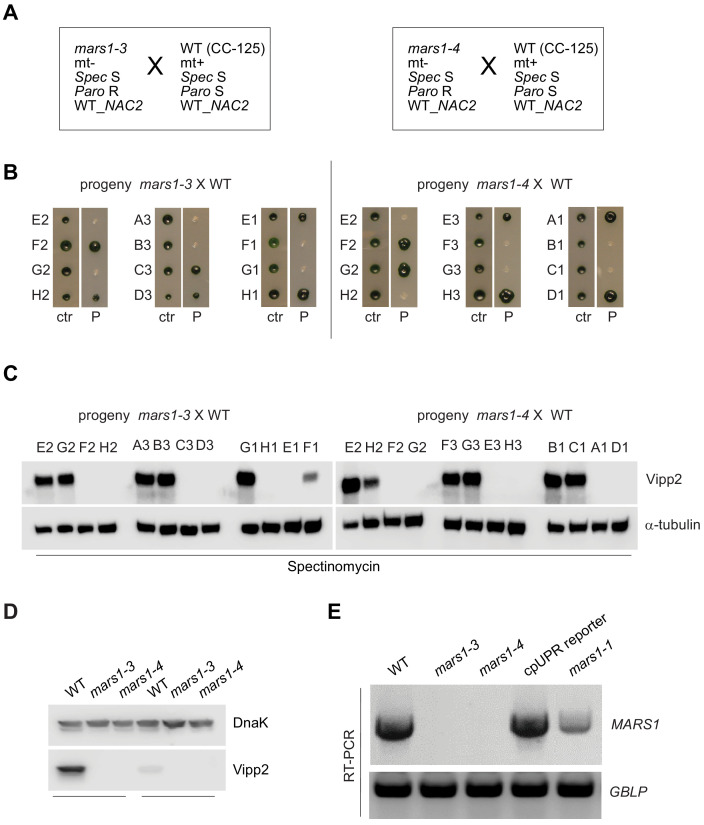
Genetic analysis of mars1-3 and mars1-4.(A) Diagram showing the backcross of mars1-3 or mars1-4 to CC-125 (WT) and indicating the mating-type and other genetic markers of these strains. (B) Photographs of offspring from the backcross of mars1-3 or mars1-4 to CC-125 (WT), re-arrayed in a 96-well format and replicated on TAP agar (‘ctr’, control) or on TAP agar supplemented with paromomycin (‘P’). Three representative tetrads are shown for each mutant. (C) Immunoblot analysis of samples prepared from tetrads obtained from the backcross of mars1-3 or mars1-4 to CC-125 (WT) (shown in Figure 2—figure supplement 4B) and treated with spectinomycin, using antibodies against Vipp2 and α-tubulin for loading control. Since these strains do not harbor a spectinomycin resistance cassette, this antibiotic was used as a chloroplast translation inhibitor to trigger the activation of the chloroplast unfolded protein response. (D) Immunoblot analysis of samples prepared from wild-type cells and mars1-3 and mars1-4 cells, upon treatment with either spectinomycin or hydrogen peroxide, using antibodies against Vipp2 and DnaK as a loading control. (E) MARS1 RT-PCRs performed on cDNA extracted from wild-type cells (CC-4533, the parental line used to generate the mars1-3 and mars1-4 mutants), mars1-3 and mars1-4 cells, cpUPR reporter cells (the parental line used to generate mars1-1) and mars1-1 cells using primers indicated in Figure 2—figure supplement 3D. RT-PCRs of the housekeeping gene GBLP served as loading controls. The insertion of the mutagenic cassette in different regions of the MARS1 gene (as indicated in Figure 2D) impairs expression of MARS1 transcript to different degrees in each mutant (completely in mars1-4, almost completely in mars1-3 and partially in mars1-1).